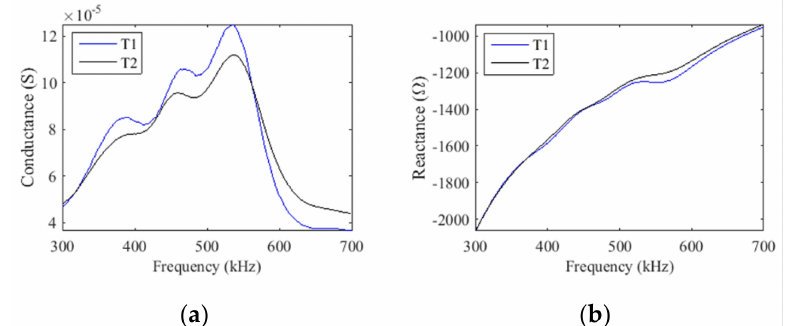
Figure 11. The electrical impedance measurements allow the identification of the resonance frequency at ( a ) the maximum conductance and ( b ) the reactance was used to calculate the matching series inductor (a measurement of the element